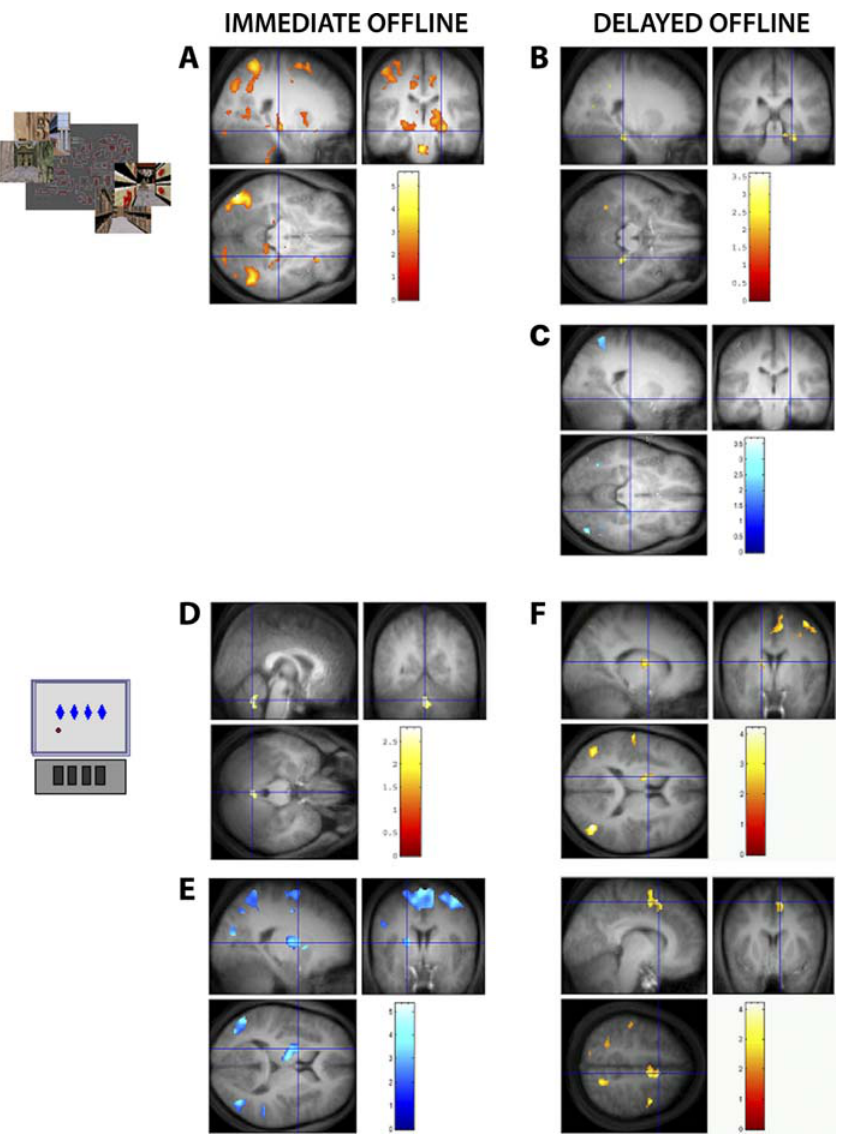
Figure 2. Task-Specific Modulation of Regional Brain Responses by Prior Learning Spatial learning-related offline activity: (A) Higher brain responses after spatial than after procedural learning in Session II (versus I). Blue cross hair on hippocampus (26 (cid:1) 24 (cid:1) 8 mm) activation superimposed on participants’ average anatomical T1-weighted MRI image. (B) Higher brain responses in the parahippocampal gyrus (26 (cid:1) 32 (cid:1) 18 mm) after a further 30-min break during Session III (versus II). (C) Co-occurring decreased brain responses in the hippocampus (22 (cid:1) 22 (cid:1) 10 mm, blue cross hair) during Session III (versus II), more after spatial than after procedural learning. Procedural learning-related offline activity: (D) Higher brain response in the medial cerebellum (2 (cid:1) 60 (cid:1) 28 mm) after procedural than after spatial learning in Session II (versus I). (E) Co-occurring decreased brain responses in the putamen ( (cid:1) 20 2 10 mm, blue cross hair), lateral cerebellum, SMA, and other neocortical areas during Session II (versus I), more after procedural than after spatial learning. (F) Higher brain response after a further 30-min break during Session III (versus II) in the caudate nucleus (top: (cid:1) 16 0 16 mm) and the SMA (bottom: 10 2 56 mm). Color bars indicate the magnitude of the effect size, in the yellow range for increased post-training brain response, and in the blue range for decreased post-training brain response. DOI: 10.1371/journal.pbio.0040100.g002